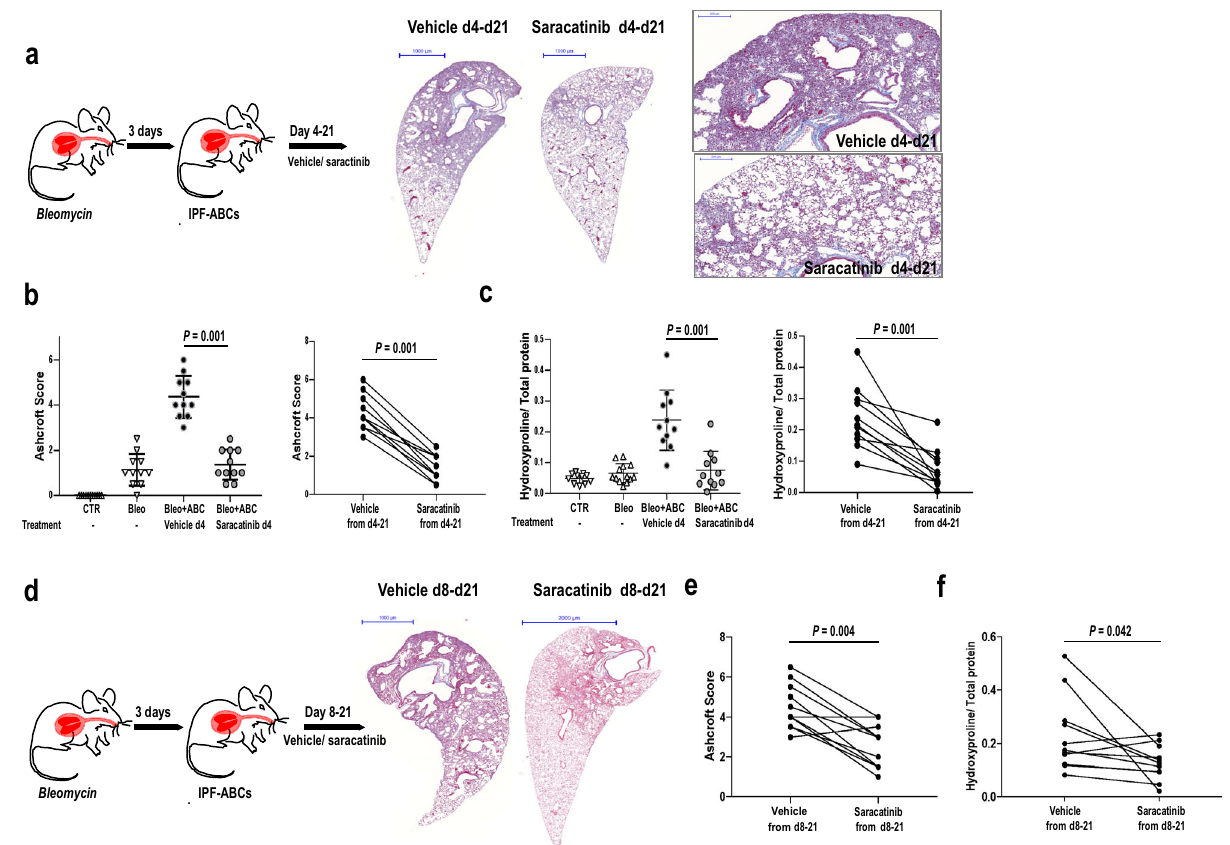
Fig. 6 | SRC-inhibitor saracatinib attenuates fi brosis in the humanized mouse model. NRG mice were intratracheally injected with a low dose of bleomycin and 3 days later withhuman ABCs derivedfrom IPF patients. Mice( n =11 eachgroup, 4 independent experiments (all data shown)) were treated oropharyngeally with or withoutsaracatinibinadoseof10mg/kgoncedailystartingatday4( a – c )oratday 8 ( d – f ). a – c Treatment with saracatinib from day 4 signi fi cantly reduced the evo- lutionof fi brosisasmeasuredbyAshcroftscore( b ,mean±SD)andhydroxyproline